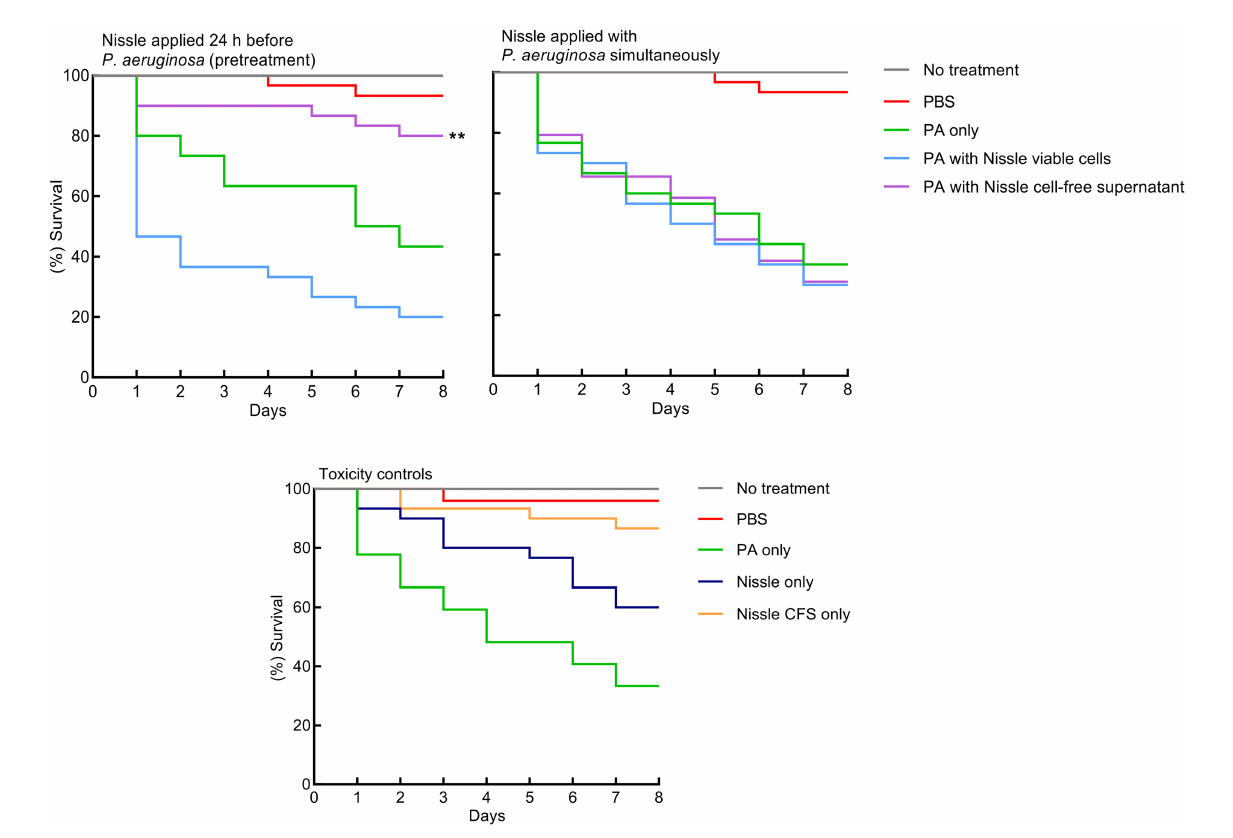
FIGURE 8 Pretreatment with E. coli Nissle cell-free supernatant (CFS) confers significant protection against P. aeruginosa toxicity in a Galleria mellonella virulence assay. Kaplan–Merier survival curves of larvae injected with Nissle cells or supernatants 24 h before, or simultaneously with P. aeruginosa . Pre- treatment with Nissle cell-free supernatant conferred significant protection to the larvae. Administration of Nissle viable cells increased larval mortality. P. aeruginosa was significantly lethal to the larvae. No significant toxic effects of the Nissle cell-free supernatant were observed. Asterisks indicate statistically significant differences ( p <